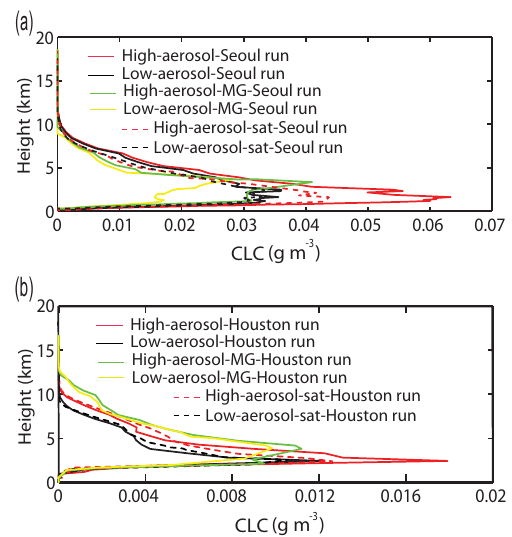
Figure 13. Vertical distributions of the time- and domain-averaged cloud liquid content (CLC) for (a) the Seoul case and (b) the Hous- ton case. Solid red and black lines represent simulations with the bin scheme and at the 500m resolution, while dashed red and black lines represent the bin-scheme simulations with the saturation ad- justment. Solid yellow and green lines represent simulations with the MG